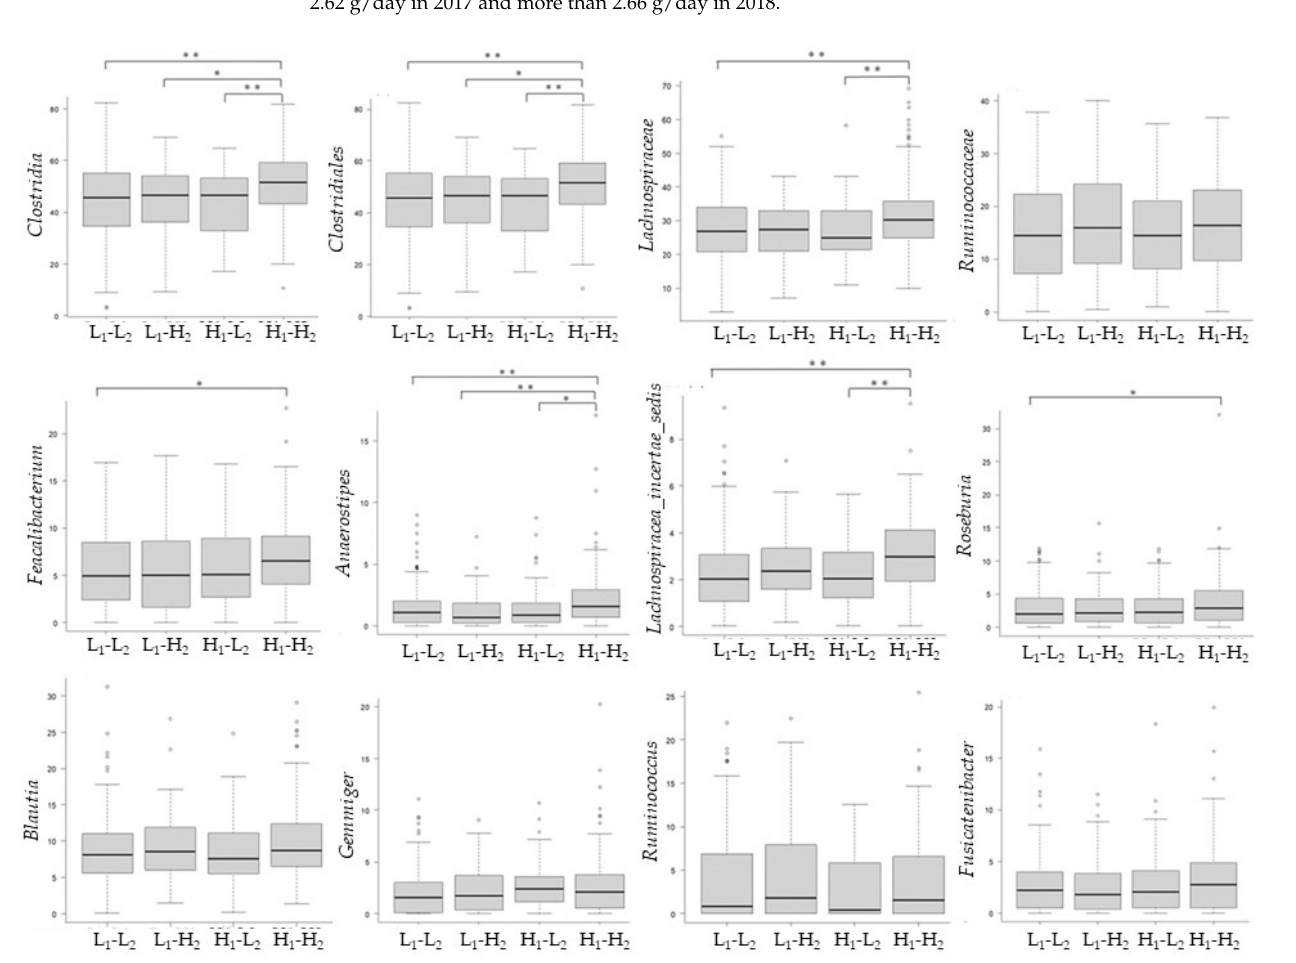
Figure 7. Comparison of butyric acid-producing bacteria among four groups classified by water- soluble dietary fiber intake from 2017 to 2018. L 1 -L 2 : Less than 2.62 g/day in 2017 and less than 2.66 g/day in 2018; L 1 -H 2 : Less than 2.62 g/day in 2017 and more than 2.66 g/day in 2018; H 1 -L 2 : More than 2.62 g/day in 2017 and less than 2.66 g/day in 2018; and H 1 -H 2 : More than 2.62 g/day in 2017 and more than 2.66 g/day in 2018. * < 0.05, ** < 0.01.